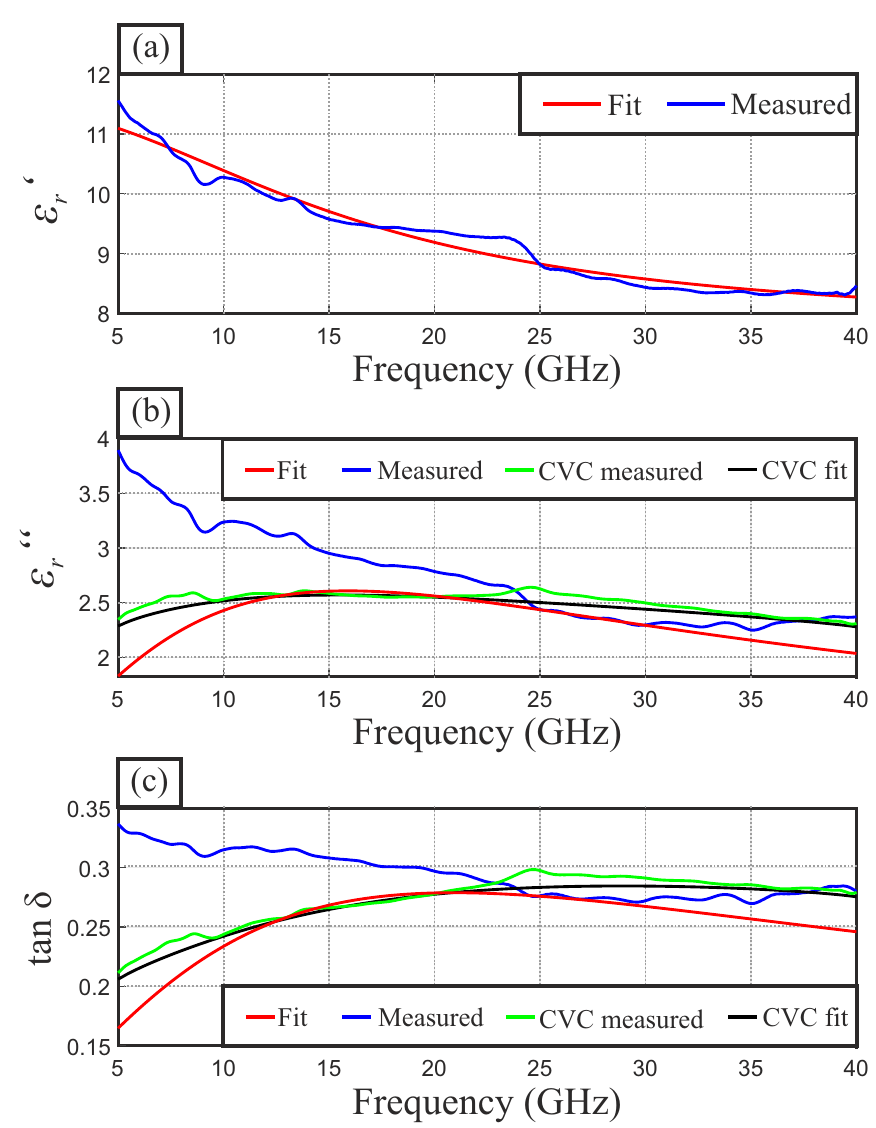
Figure 6. Exemplary results of the mixed material investigation at an carbon black volume fraction of ζ cb = 0.07 , indicating the real ( a ) and imaginary part ( b ) permittivity as well as the loss tangent ( c ) for (—) measured values, (—) Debye model fitted values, (—) CVC of measured values and (—) CVC of Debye model fitted